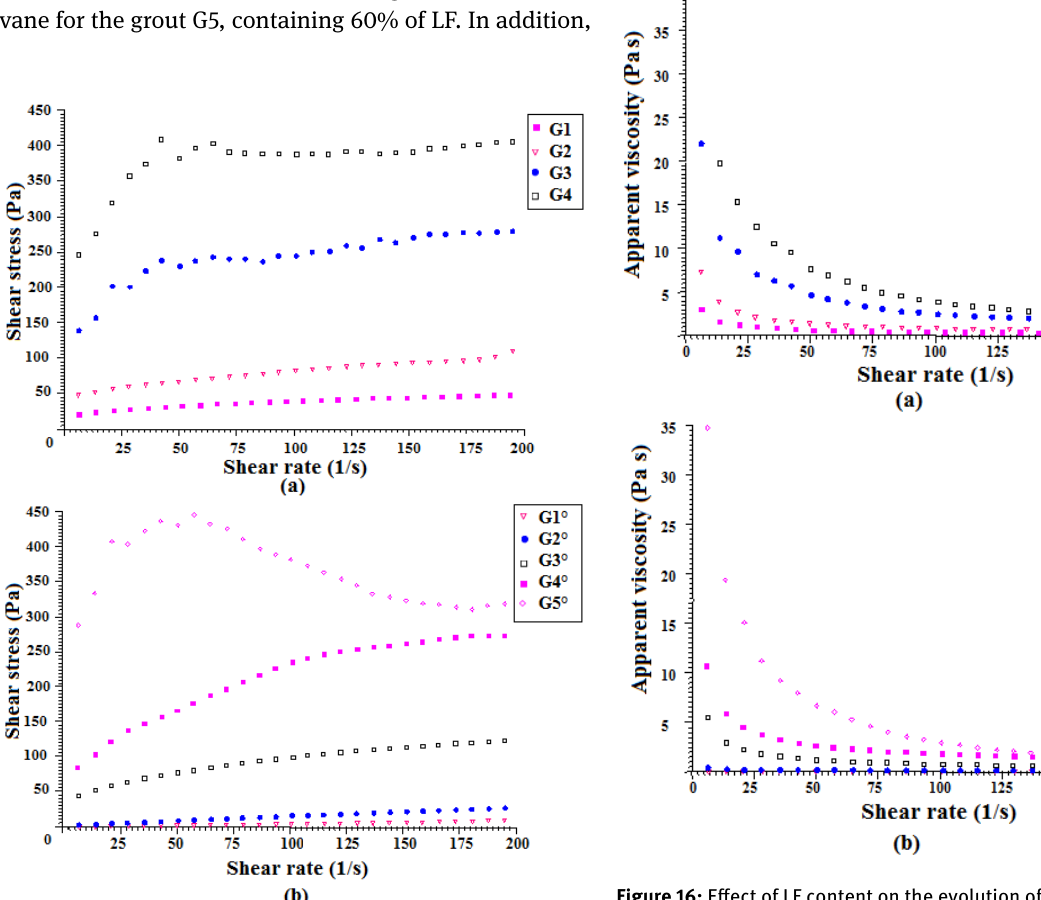
Figure 16: Effect of LF content on the evolution of the apparent viscosity with shear rate of the cement grout (a) without Sp and (b) with